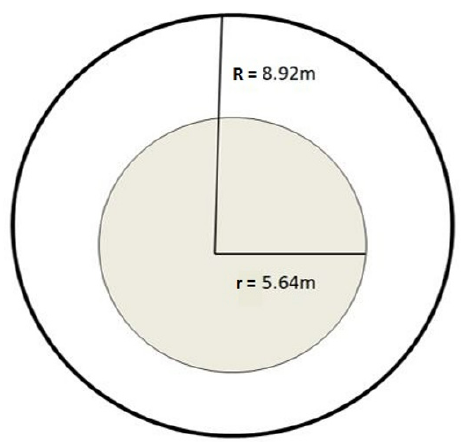
Figure 3. Sample plot layout. Note: R = radius plot for AGTB, r = radius plot for